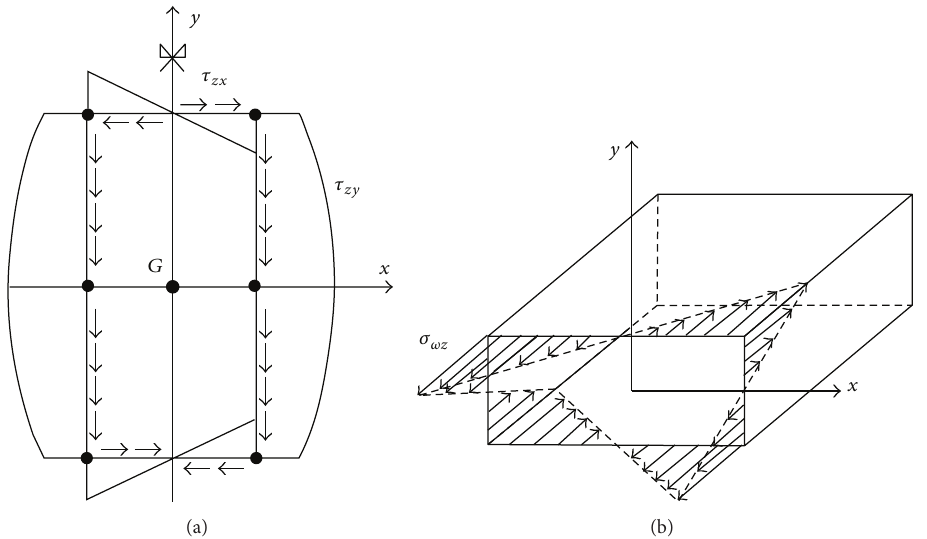
Figure 4: Stress distribution along rectangular cross-sections, due to vertical shear ( 𝜏 𝑧𝑥 and 𝜏 𝑧𝑦 in (a)) and warping torsion ( 𝜎 𝑧 in (b)): the global effect of linear parts in the central node is zero.